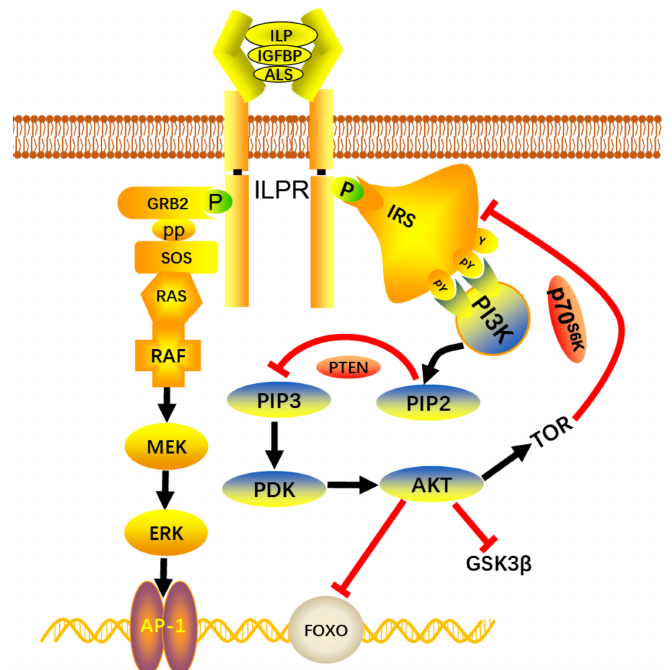
Figure 9. The proposed model of the role of the ILPR-mediated and IIS signaling pathways in the growth regulation of C. gigas . The binding of the insulin-like peptide to its receptor (ILPR) induces conformational changes in the alpha and beta subunits of the receptor. The IRS binds to the activated sites of the beta subunits and transduces signal to the cell through the PI3K-AKT and RAS-MAPK signaling pathways. The other elements, including PTEN, GSK3 β , FoxO, and TOR, could regulate the activation of the PI3K-AKT signaling pathway in C. gigas through a similar mechanism as in vertebrates. The rapamycin-sensitive TORC1 (TOR complex 1) activates the translational regulator S6K (S6 kinase), leading to increased protein synthesis in the presence of nutrients, and the S6K could inhibit the activity of the IRS, finally regulating the PI3K-AKT and RAS-MAPK signaling pathways. Arrow (black line) and inhibitory sign (red line) indicate promotion and suppression,